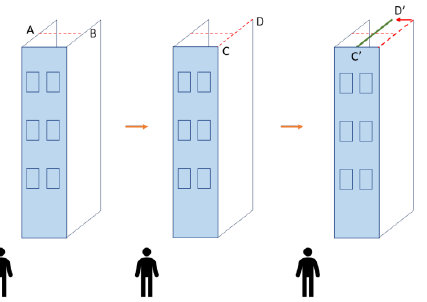
Figure 21. The digitized process of the possible cadastral detail line between townhouse.